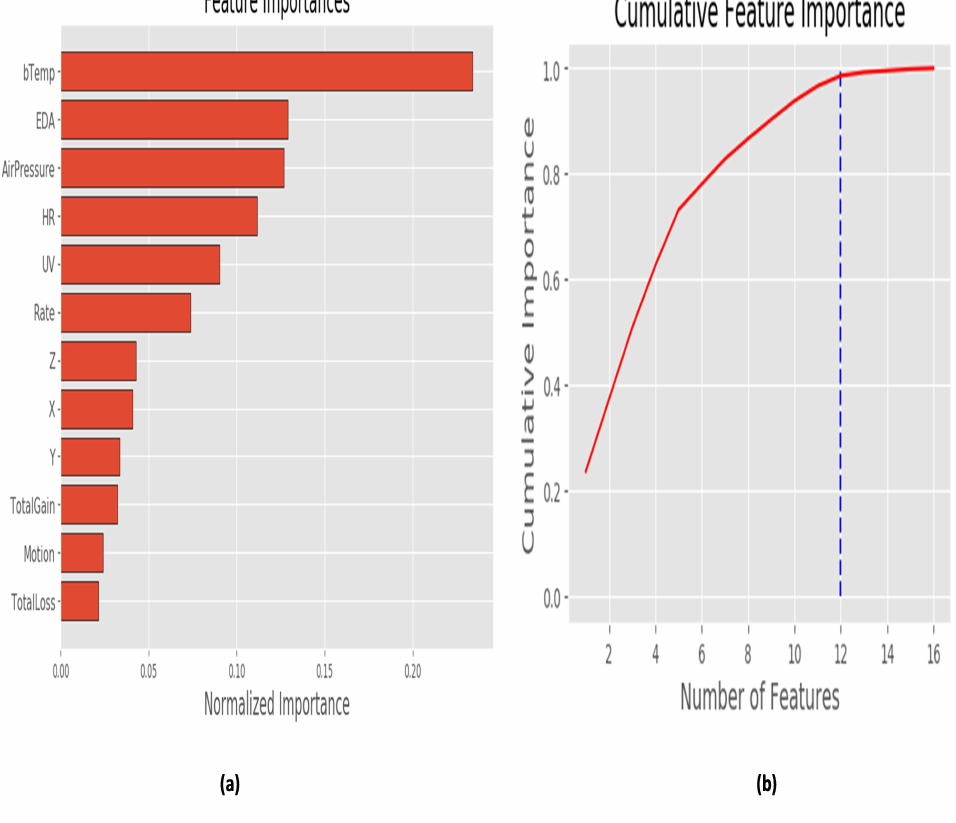
Figure 10. ( a ) Importance of Physiological and Environmental Features. ( b ) Cumulative Importance of These